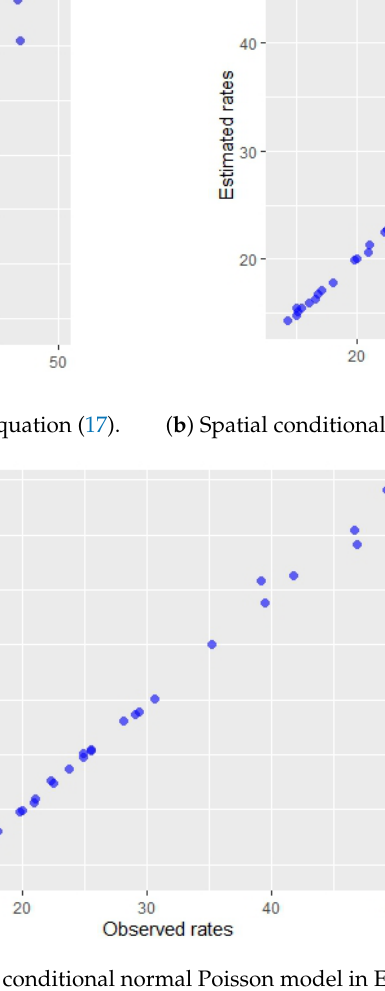
Figure 5. Scatterplots for the observed versus the predicted rates obtained from some of the fitted models to the Colombia infant mortality rates data